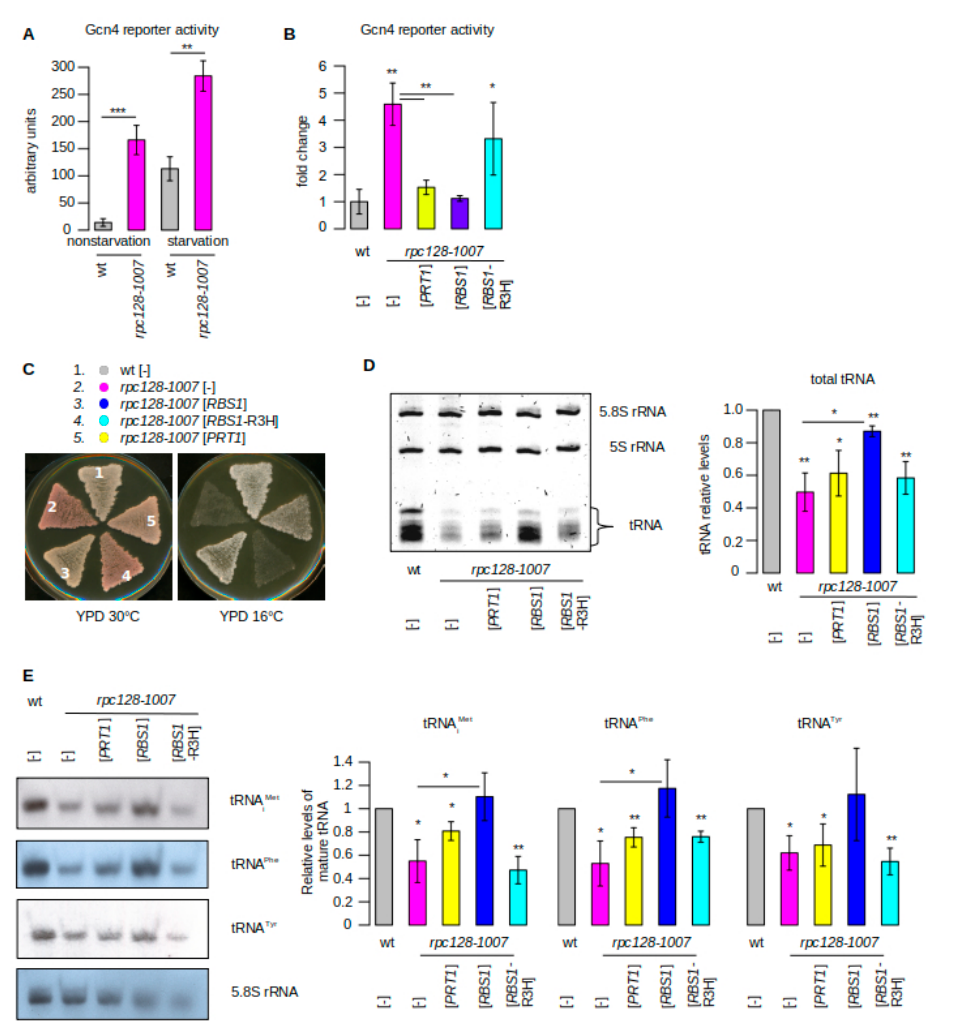
Figure 1. RBS1 and PRT1 as overdose suppressors of the Pol III assembly mutant rpc128-1007 . ( A ) Expression of the GCN4-lacZ in rpc128-1007 mutant. The rpc128-1007 mutant and isogenic wild-type strains, transformed with p180 plasmid ( GCN4-lacZ , CEN , URA3 ), were grown under nonstarvation or starvation conditions, as described in the Materials and Methods section. Extracts were prepared and assayed for β -galactosidase activity (expressed as nanomoles of o -nitrophenol- β -D-galactopyranoside hydrolyzed per minute per microgram of total protein). The reported values are averages of three independent measurements (number of biological replicates n = 3). ( B – D ) The rpc128-1007 mutant was transformed with a control empty vector [–] or multicopy plasmids [ PRT1 ], [ RBS1 ], and [ RBS1 -R3H]. ( B ) The effect of suppressors on GCN4-lacZ expression. Cells harboring p180 plasmid ( GCN4-lacZ , CEN , URA3 ) were grown in YPD, harvested in log phase. β -galactosidase activity was determined and calculated relative to the amounts in the wt strain, which was set as 1 ( n = 3). ( C ) Suppression of the rpc128-1007 growth phenotype. Cells that were grown on a YPD plate were replicated on YPD plates and incubated for three days at the respective temperatures. ( D ) Determination of total tRNA levels. Small RNA species were isolated and separated on a 7 M urea–6% polyacrylamide gel using equal amounts of RNA per lane (2.5 µ g) and stained with ethidium bromide ( n = 3). (E) Determination of specific tRNA levels by northern hybridization with probes specific for mature tRNA iMet , tRNA Phe , and tRNA Tyr . tRNA amounts in D and E were normalized to the loading control (5.8 S rRNA) and calculated relative to amounts in the wt strain, which was set as 1. Bars represent the mean ± standard deviation (SD) of three independent experiments ( n = 3). Values of p were calculated using a two-tailed paired t -test: * p < 0.05; ** p < 0.01; *** p < 0.001. Asterisks just under bars show the p -value in comparison to the level in wt; other comparisons are annotated by lines. To clarify the plots, bars are colored as follows: rpc128-1007 with control vector—pink; with [ PRT1 ], [ RBS1 ], and [ RBS1 -R3H]—yellow, dark blue, and light blue, respectively; grey was used for control strains. The same color code and calculation of p -values are used in the figures